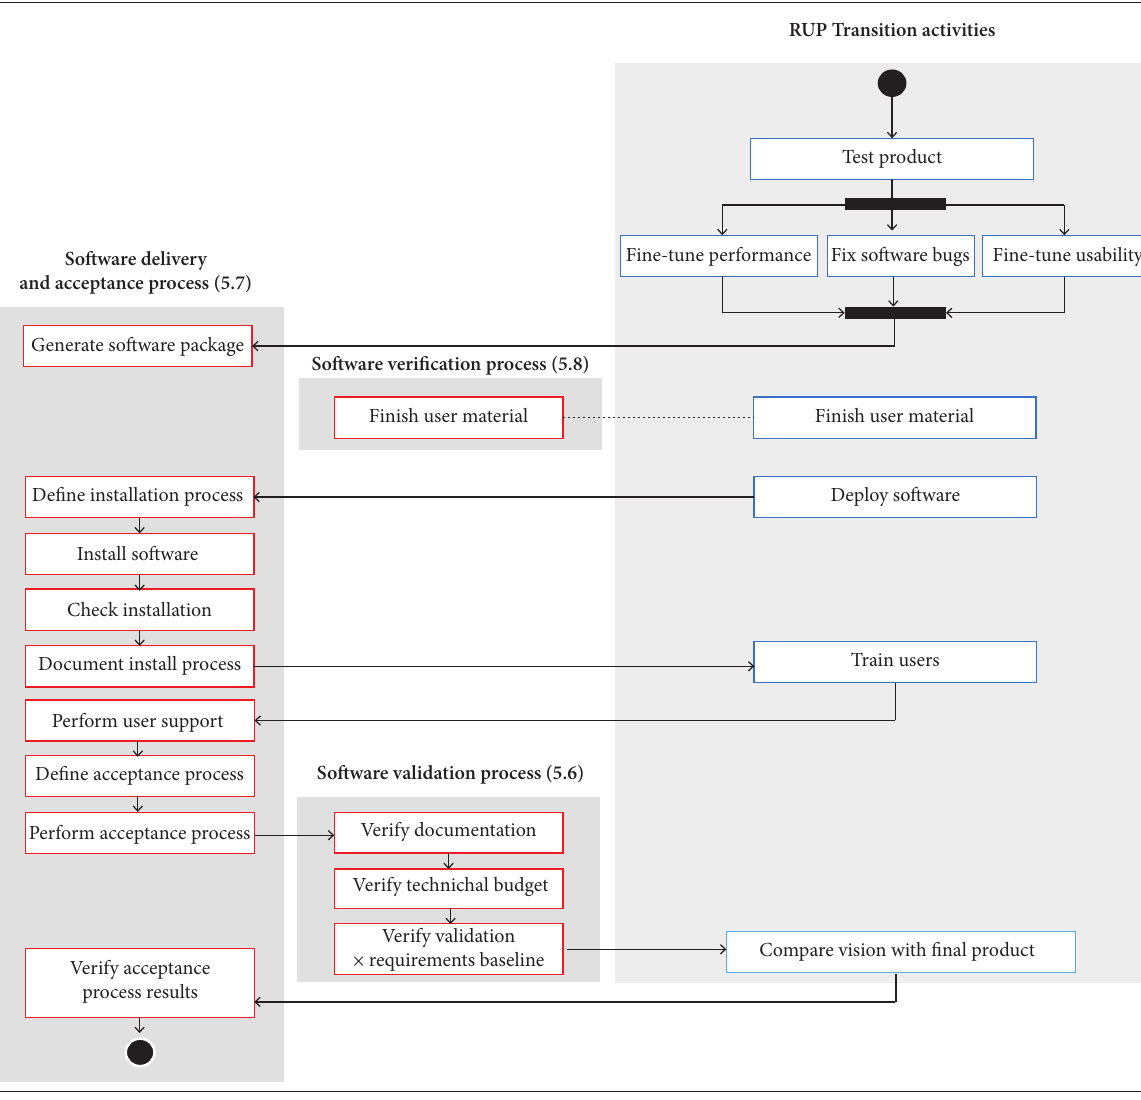
figure 10. Transition phase activities for the